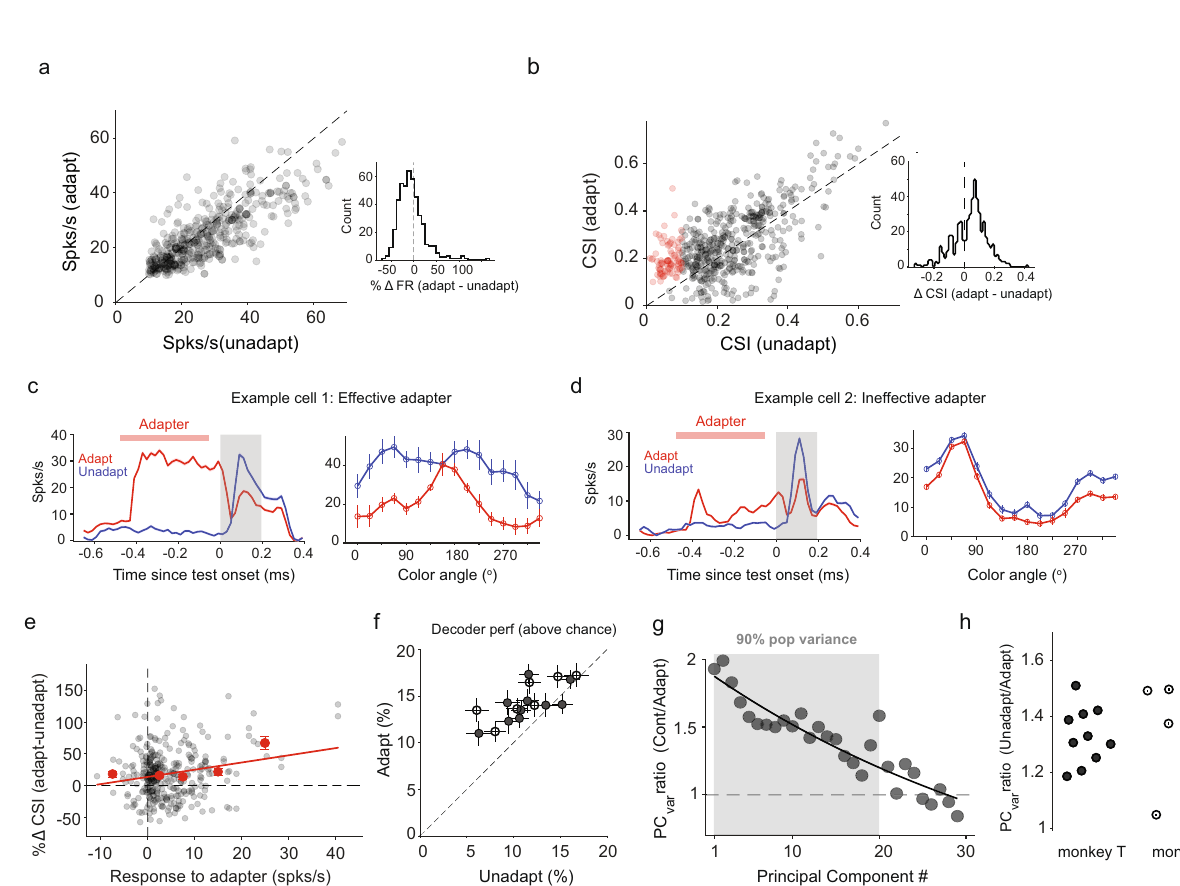
Fig.3|Crossfeatureadaptationmodulatesstimuluscoding.a Neuralresponses ( n =388) to color stimuli for adapted and unadapted trials. Inset: Distribution of percent differences in responses (adapt – unadapt). b Color selectivity index (CSI) of neurons in adapted and unadapted conditions. Red circles represent color untuned neurons in the unadapted condition that gained signi fi cant color tuning after orientation adaptation. Inset: distribution Δ CSI values (adapt – unadapt, Δ CSI mean = 0.04). c Post stimulus time histogram (PSTH) averaged over adapted (red) and unadapted trials (blue) of an example neuron (left) strongly activated by aneffectiveorientedadapteranditsassociatedtuningcurveunderbothconditions (right).Red barand grayshaded regionrepresent presentation ofadapter and test stimuli. d A different example cell showing weak activation by an ineffective adapter (left) and associated tuning curves under both conditions (right). Solid lines and shaded regions represent mean values and s.e.m respectively. e Percentage change in CSI for neurons ( n = 283) that were signi fi cantly tuned under both adapted and unadapted conditions as a function of the baseline